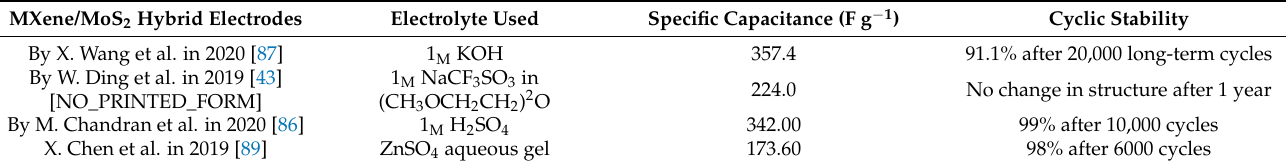
Table 3. Recent electrochemical performances for the MXene/MoS 2 hybrid electrode. Electrolyte